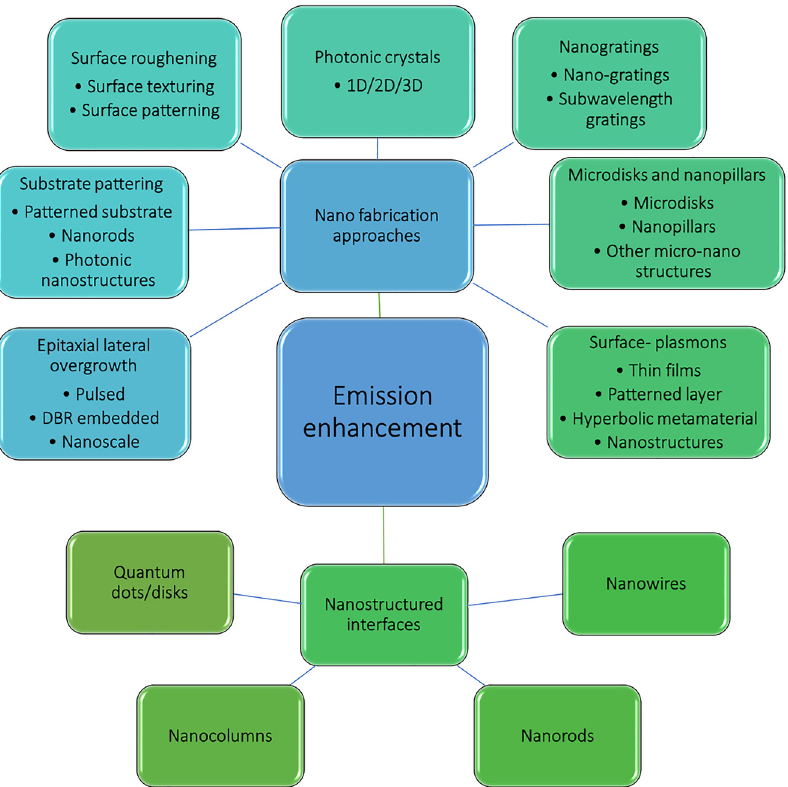
Figure 5: Overview of approaches to nanostructuring the perovskite, interfaceor substrate to boost emission efficiency beyond material